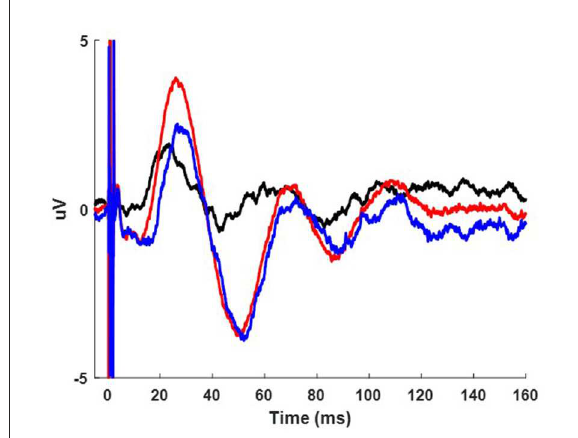
FIGURE3 Example cortical evoked potential response during the paired pulse condition from participant 3 while on medication from the FC2 electrode. The 1.5 ms IPI (red) condition is shown overlaid on the single pulse condition (black) and resulting cortical waveform from subtracting the single pulse condition from the paired pulse condition